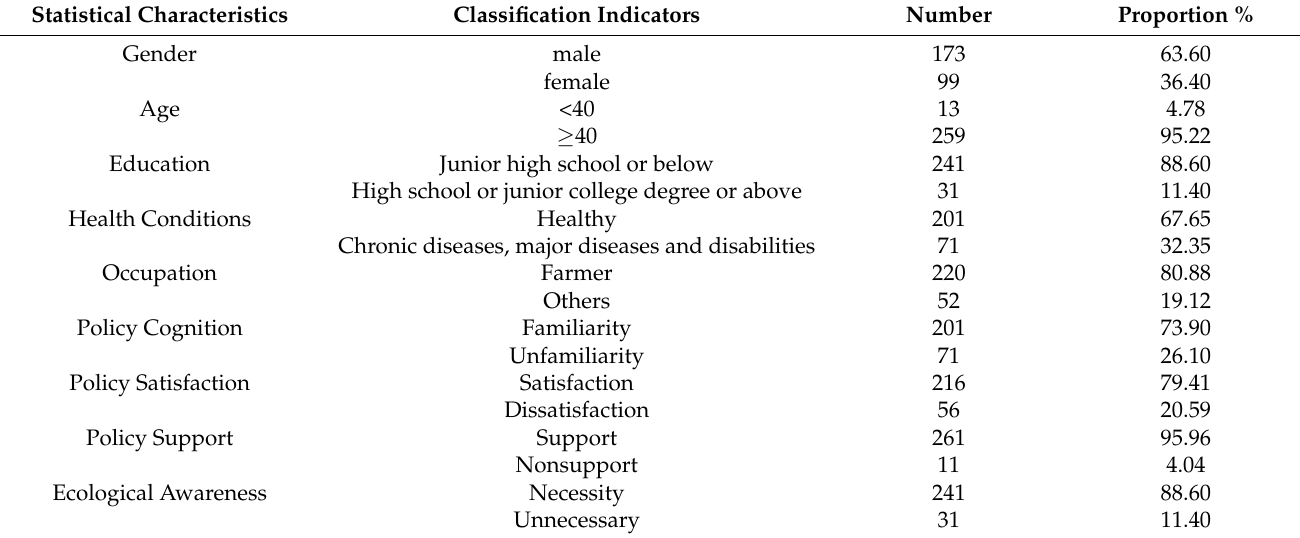
Table 3. Statistics of basic characteristics of peasant households.